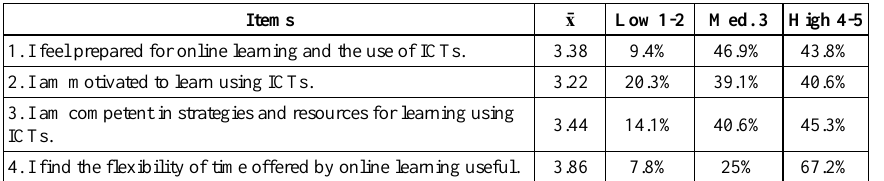
Table 1. Results of the closed